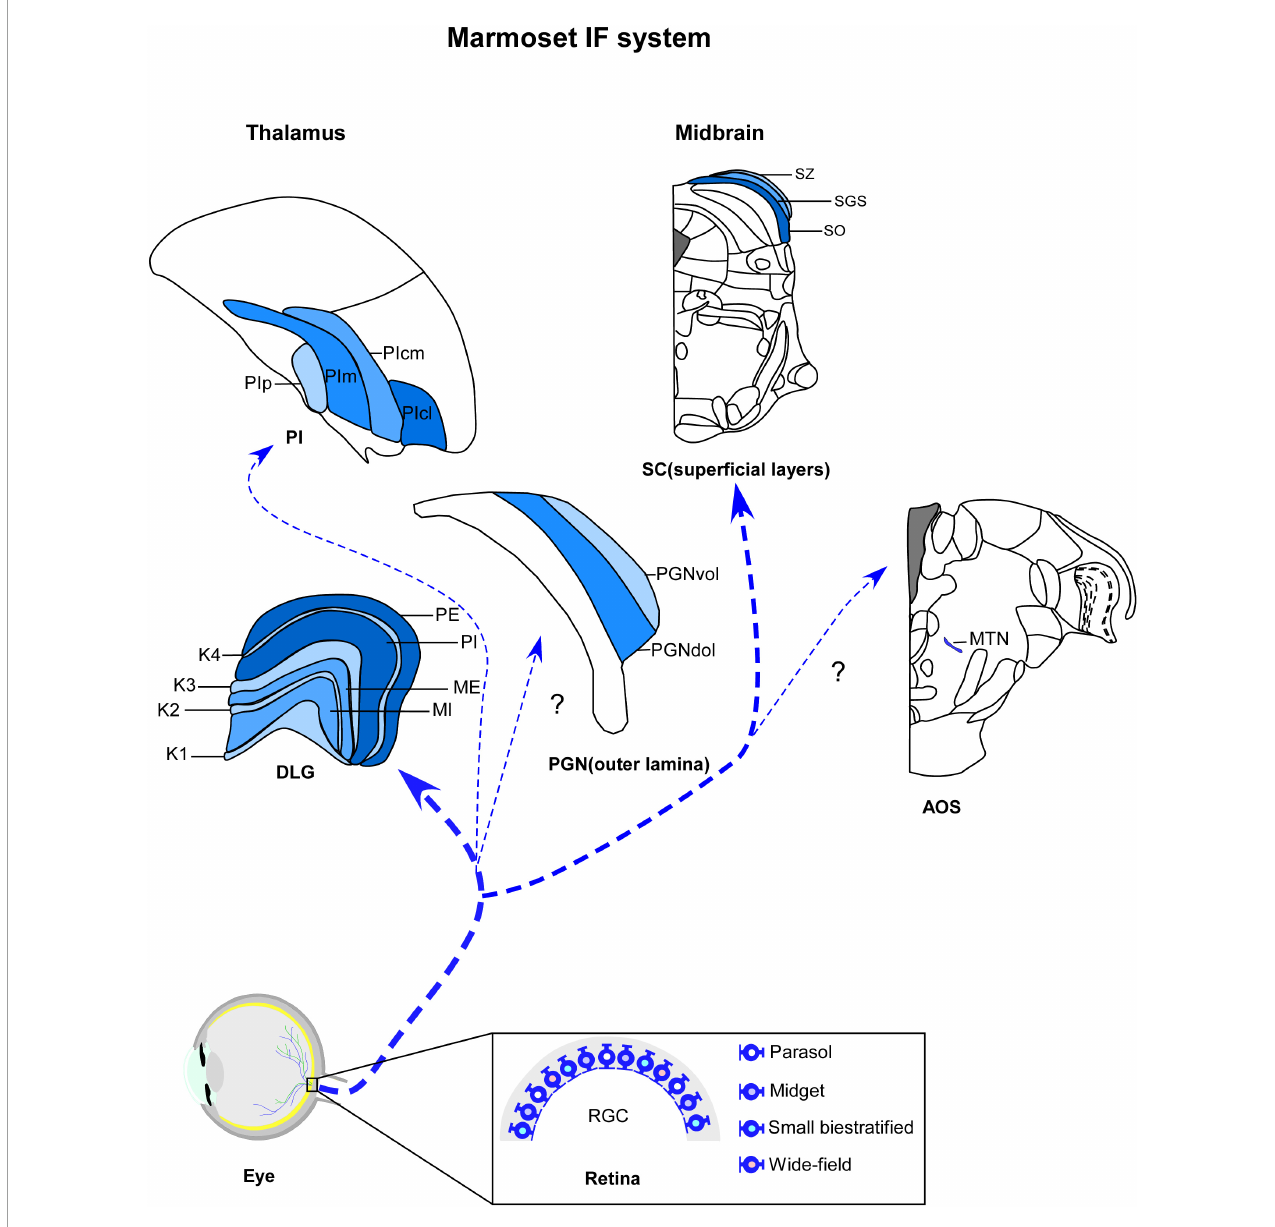
FIGURE1 Schematic representation of marmoset image-foming system (blue). Distinct types of retinal ganglion cells (RGCs) bilaterally innervate visual thalamic and midbrain nuclei, such dorsal lateral geniculate nucleus (DLG), inferior pulvinar (PI), outer lamina of the pregeniculate nucleus (PGNol) and superficial layers of superior colliculus (SC). Parasol, midget and small bistratified cells send axonal projections to parvocellular, magnocellular and koniocellular layers of DLG, respectively. SC receives dominant projections from parasol cells. Additional wide-field cells, such as narrow thorny, broad thorny and recursive cell has been described as sending projections to K laminae, CS and PI. The RGC populations that innervates the PGNol, pretectal nuclei and accessory optic nuclei (AOS) still remain unclear. K1–K4, koniocellular layers 1–4; ME, external magnocellular layer; MI, internal magnocellular layer; PE, external parvocellular layer; PGNdol, pregeniculate nucleus dorsal outer lamina; PGNvol, Pregeniculate nucleus ventral outer lamina; PE, internal parvocellular layer; PIcl, central lateral nucleus of the inferior pulvinar; PIcm, central medial nucleus of the inferior pulvinar; PIm, medial nucleus of the inferior pulvinar; Pip, posterior nucleus of the inferior pulvinar; PM, medial pulvinar; PL, lateral